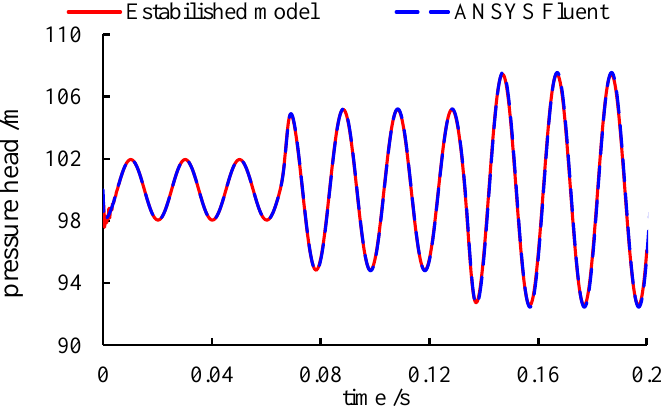
Figure 8. Pressure variation at the center of the vibration region ( T = 20 µ m, f = 50 Hz).